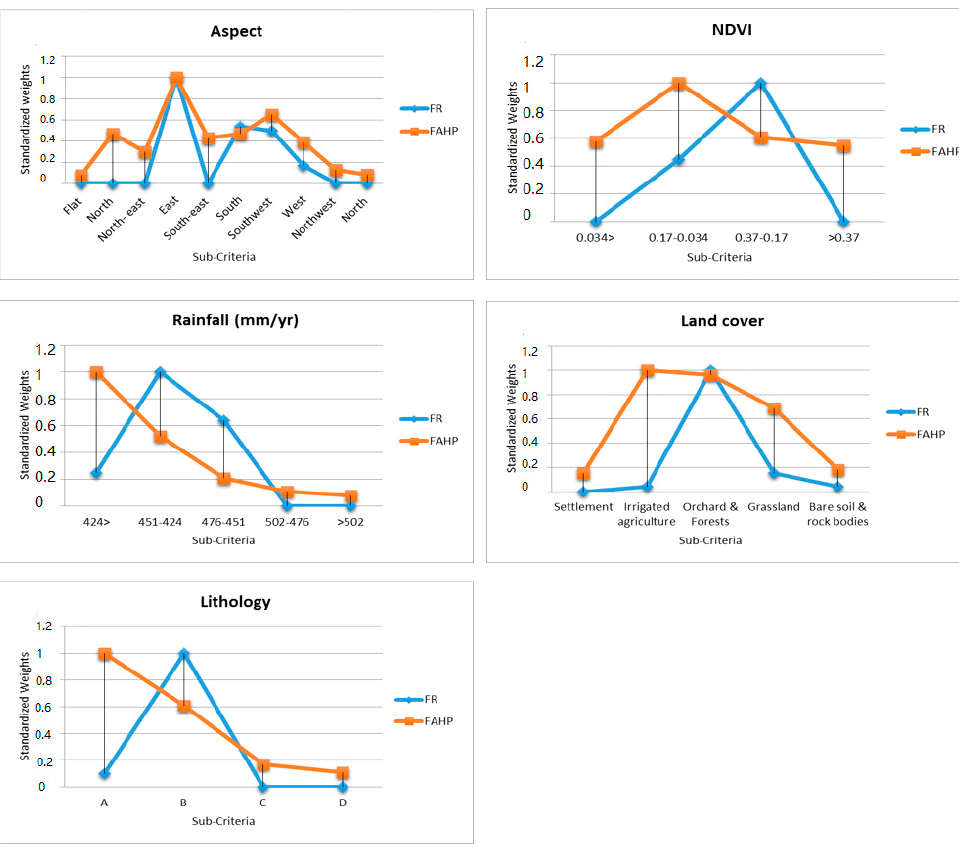
Figure 13. The comparison of the frequency ratio (FR) and FAHP weights for each class of conditioning factors.